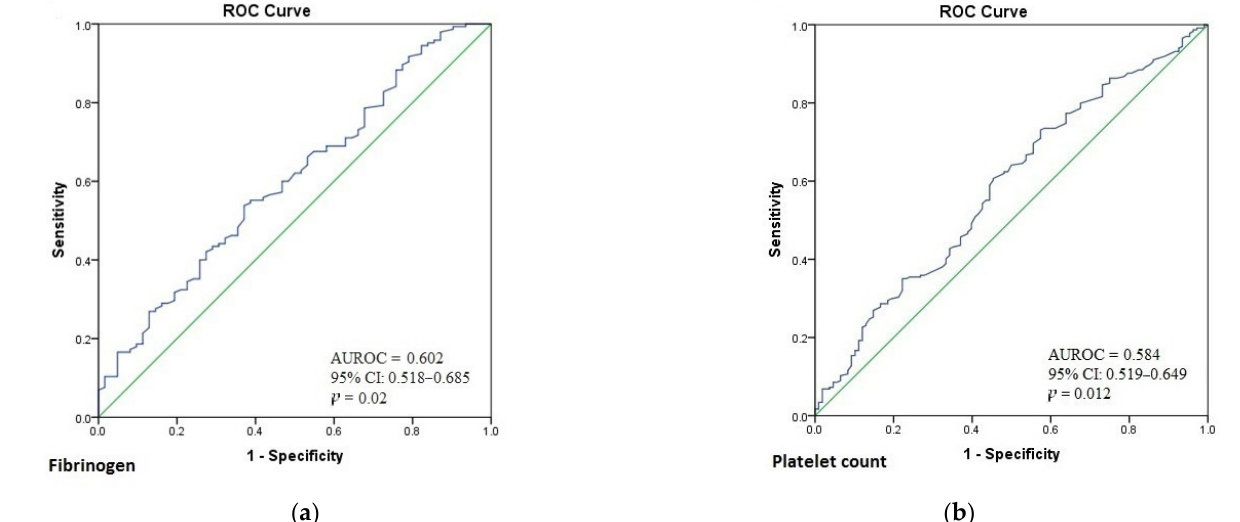
Figure 2. ( a ) Receiver operating characteristic (ROC) curve for the predictive value of fibrinogen on the presence of PTC; ( b ) Receiver operating characteristic (ROC) curve for the predictive value of platelet count on the presence of PTC. Table 1. Clinical and laboratory characteristics of the study population.